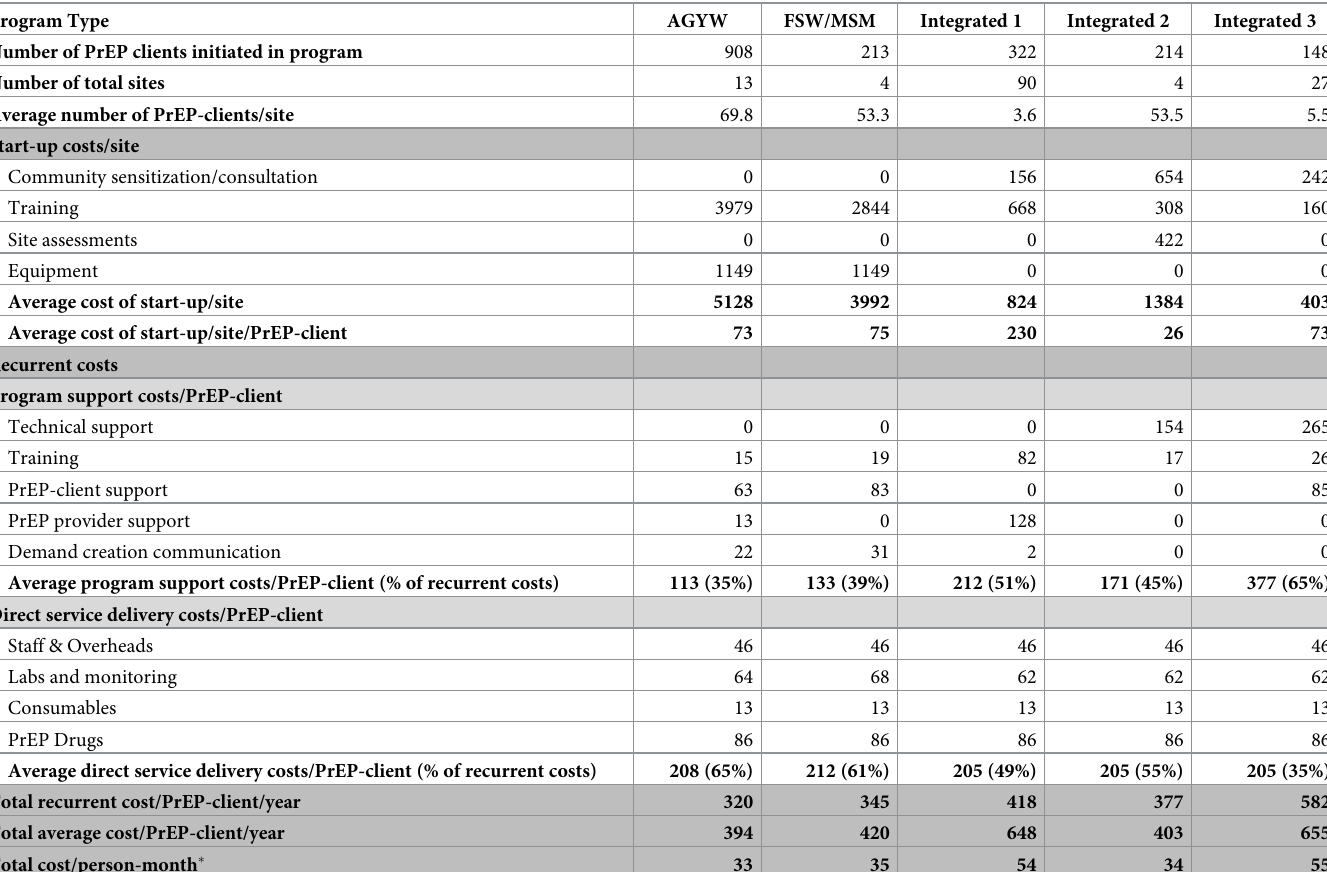
Table 4. 2018 costs of PrEP-provision according to Zambian guidelines